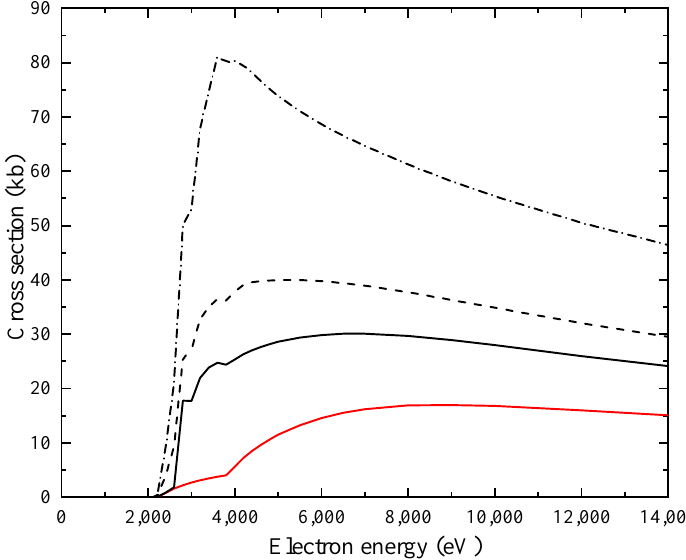
Figure 8. The total electron-impact single ionization cross-section for W 43 + . Red solid curve: LLDW calculations for direct ionization. Black solid curve: the total cross-section which contains 3 d → nl excitation cross-sections with full branching. Black dashed curve: the total cross-section which contains 3 d → nl and 3 p → nl excitation cross-sections with full branching. Black dot–dashed curve: LLDW calculations for direct and indirect ionization with unit branching (1.0 kb = 10 − 21 cm 2